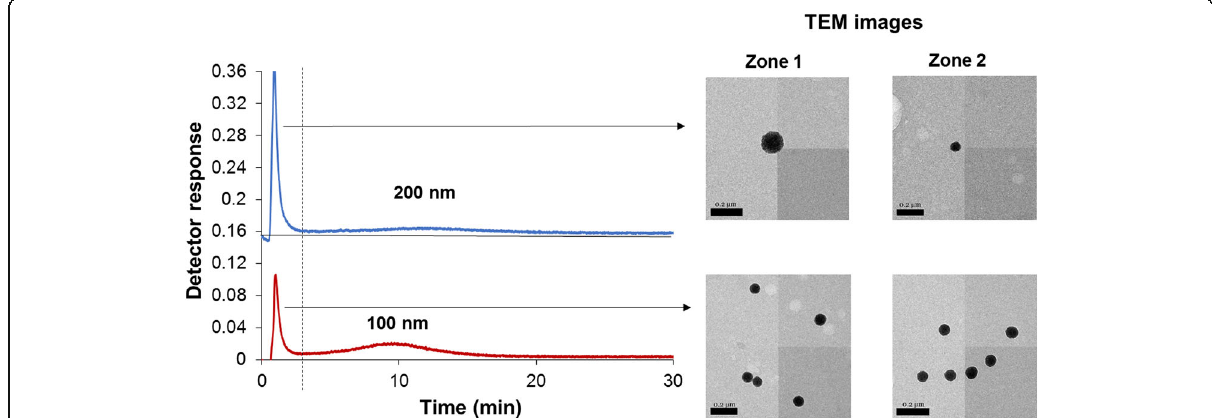
Fig. 2 TEM images of the collected void fractions in use of RC 1 kDa obtained from the injection of silica nanoparticles 100 nm and 200 nm, with 0.02% FL-70 with 0.02% NaN 3 as carrier solutions. Zone 1 and zone 2 were from different area in TEM grid